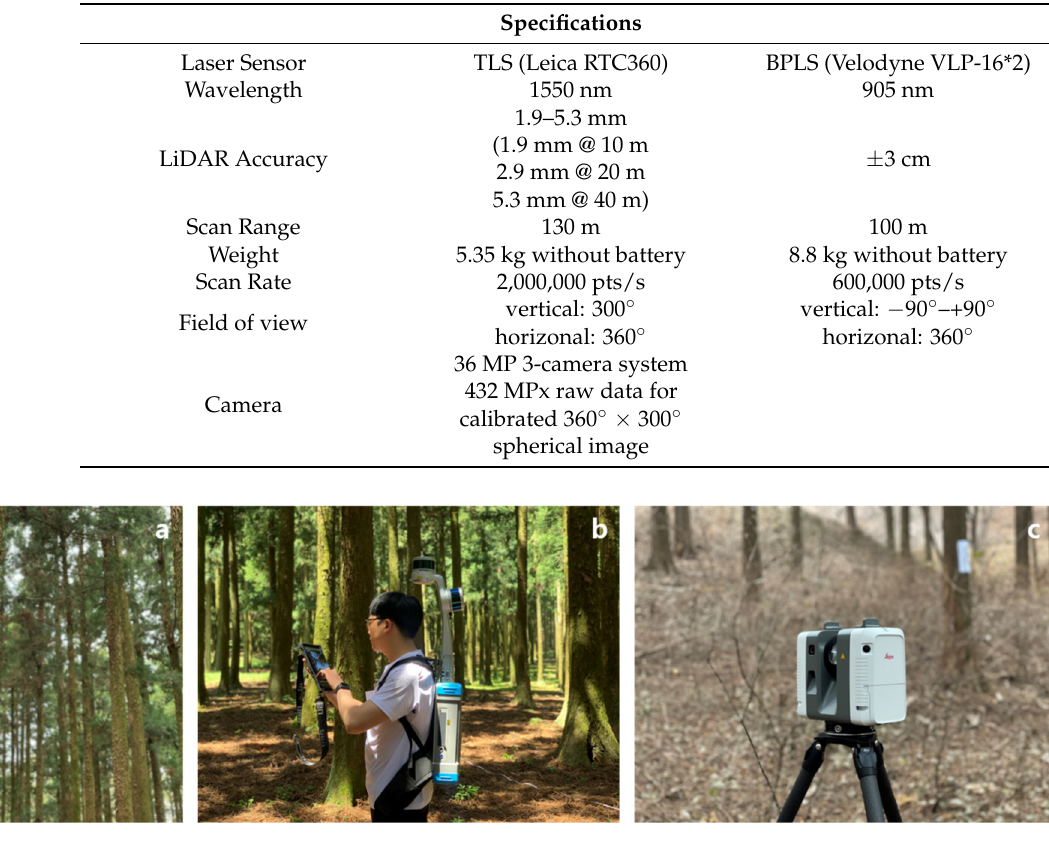
Figure 2. Photographs of the survey using ( a ) Vertex Laser Geo, ( b ) LiBackpack D50, and ( c ) RTC360.